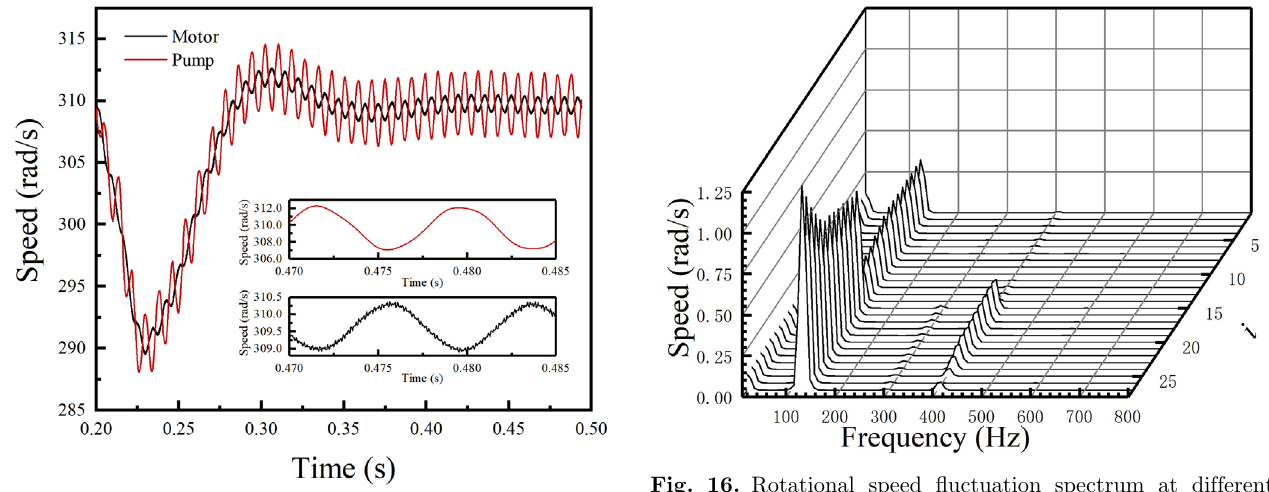
Fig. 14. Calculation result of impeller ’ s transient speed.